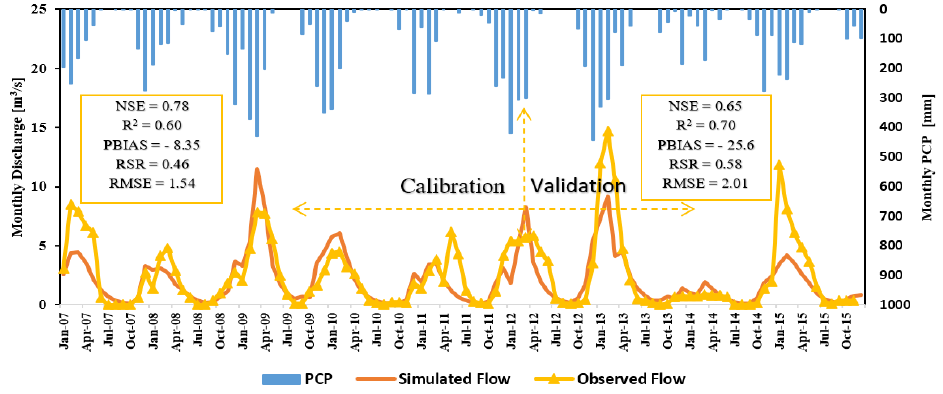
Figure 7. Monthly flow results of SWAT model simulation at station F.2 (Mayrouba) as compared to historical recorded flows (PCP = precipitation).